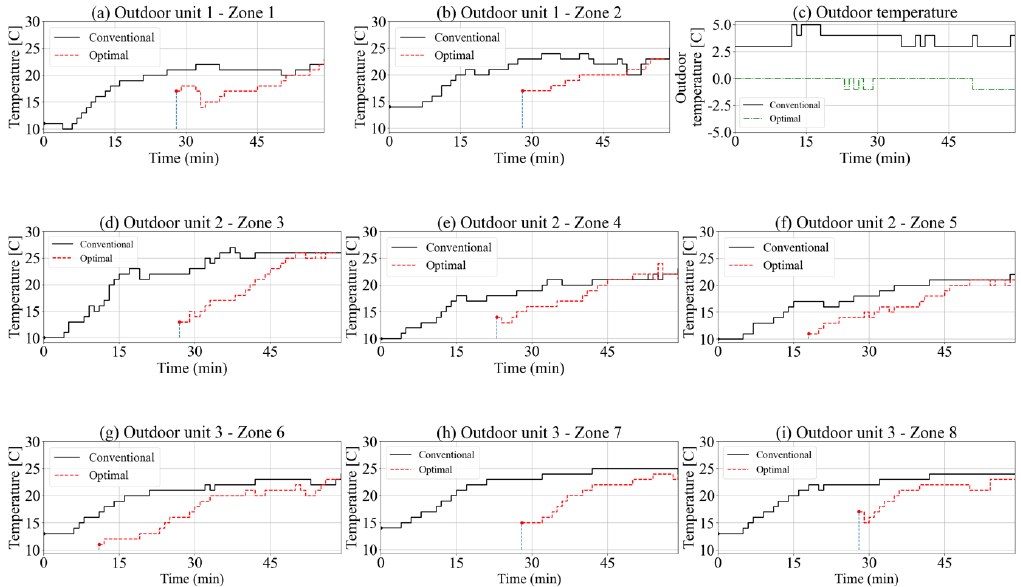
Figure 7. Comparison of the optimal control effect by indoor and outdoor units (day 5): ( a , b ) outdoor unit 1, ( c ) outdoor temperature, ( d – f ) outdoor unit 2, ( g – i ) outdoor unit 3.